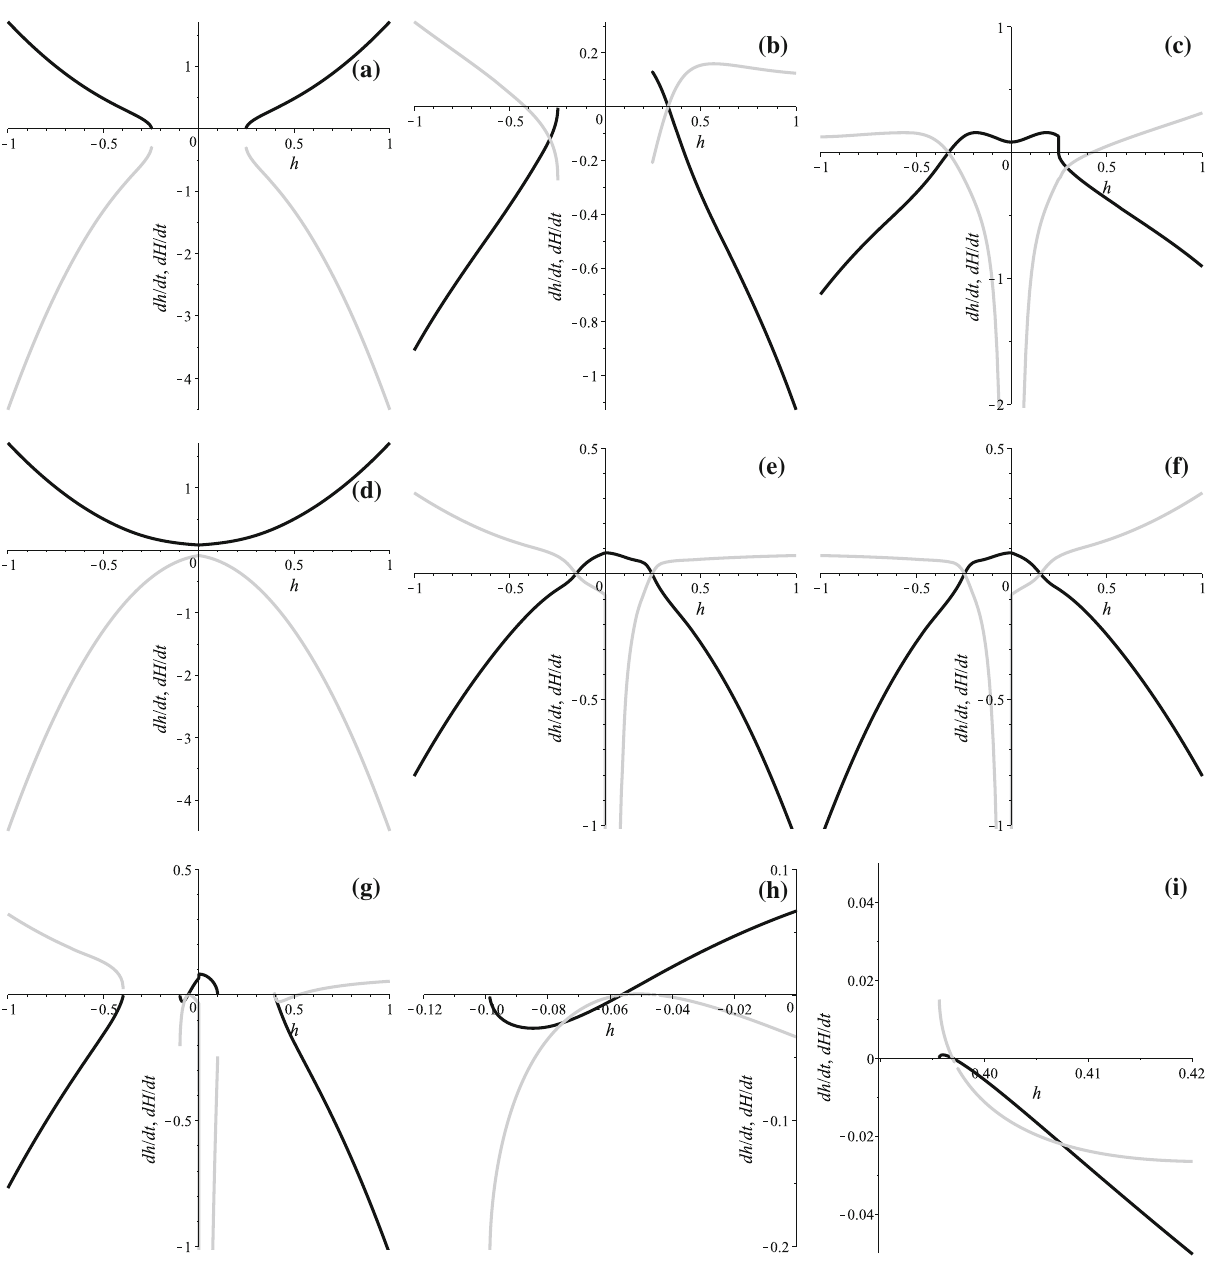
Fig. 2 ˙ h ( h ) ( black ) and ˙ H ( h ) ( gray ) curves for α < 0 D = 3 (cid:2)